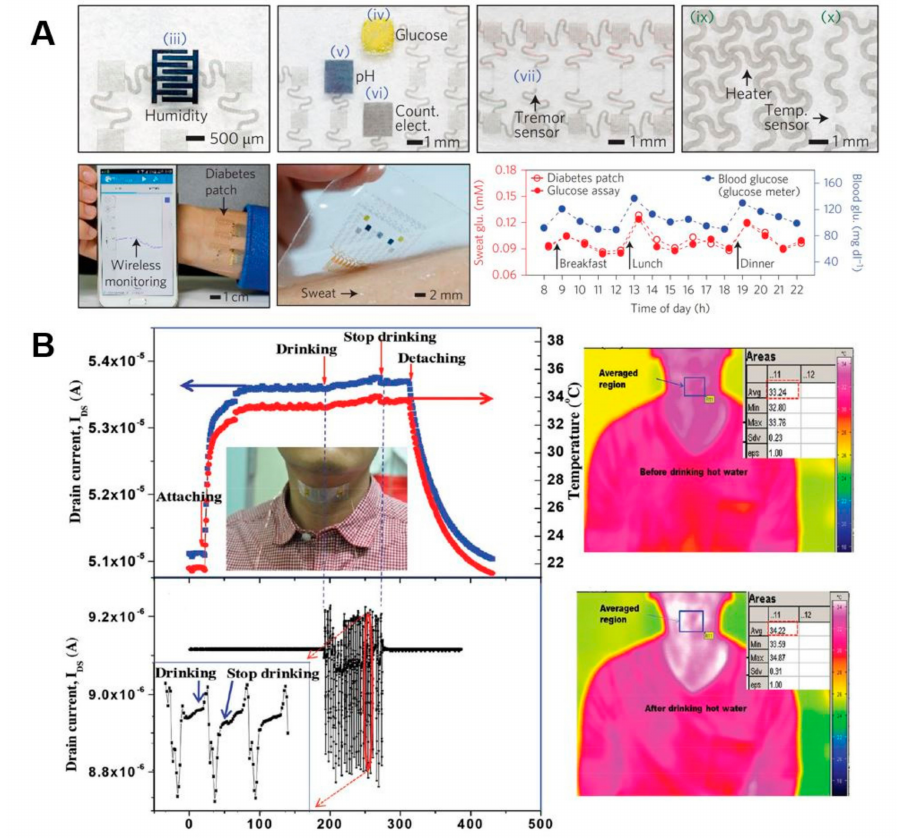
Figure 4. Flexible and stretchable sensing platforms. ( A ) Optical images of patch consisting of a humidity, glucose, pH, tremor, heater and temperature sensor. The diabetes patch is laminated on the human skin and is connected to a portable electrochemical analyzer with external devices via Bluetooth. Sweat glucose concentrations measured by the diabetes patch (red circles) and a commercial glucose assay kit (red dots) are well matched. In addition, changes in the sweat glucose concentration are well correlated with those of the blood glucose concentration. ( B ) The transparent and stretchable integrated platform of temperature and strain sensors shows the simultaneous responses to temperature of human skin during muscle movements or drinking of hot water when the integrated sensor platform was placed on the neck of a male subject. Reproduced with permission from Lee, H.; et al. A graphene-based electrochemical device with thermoresponsive microneedles for diabetes monitoring and therapy; Springer Nature, 2016 [76], and Trung, T.Q.; et al. An all-elastomeric transparent and stretchable temperature sensor for body-attachable wearable electronics; Wiley, 2016